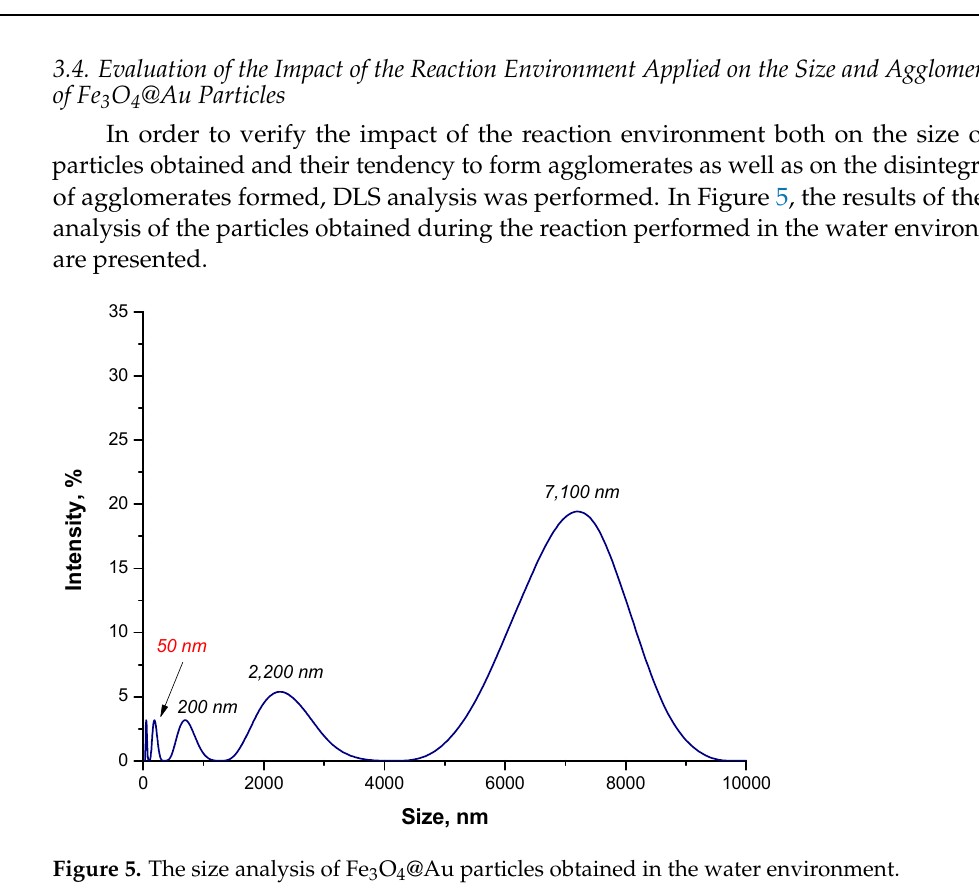
Table 1. Parameters determining the crystallinity of obtained particles.